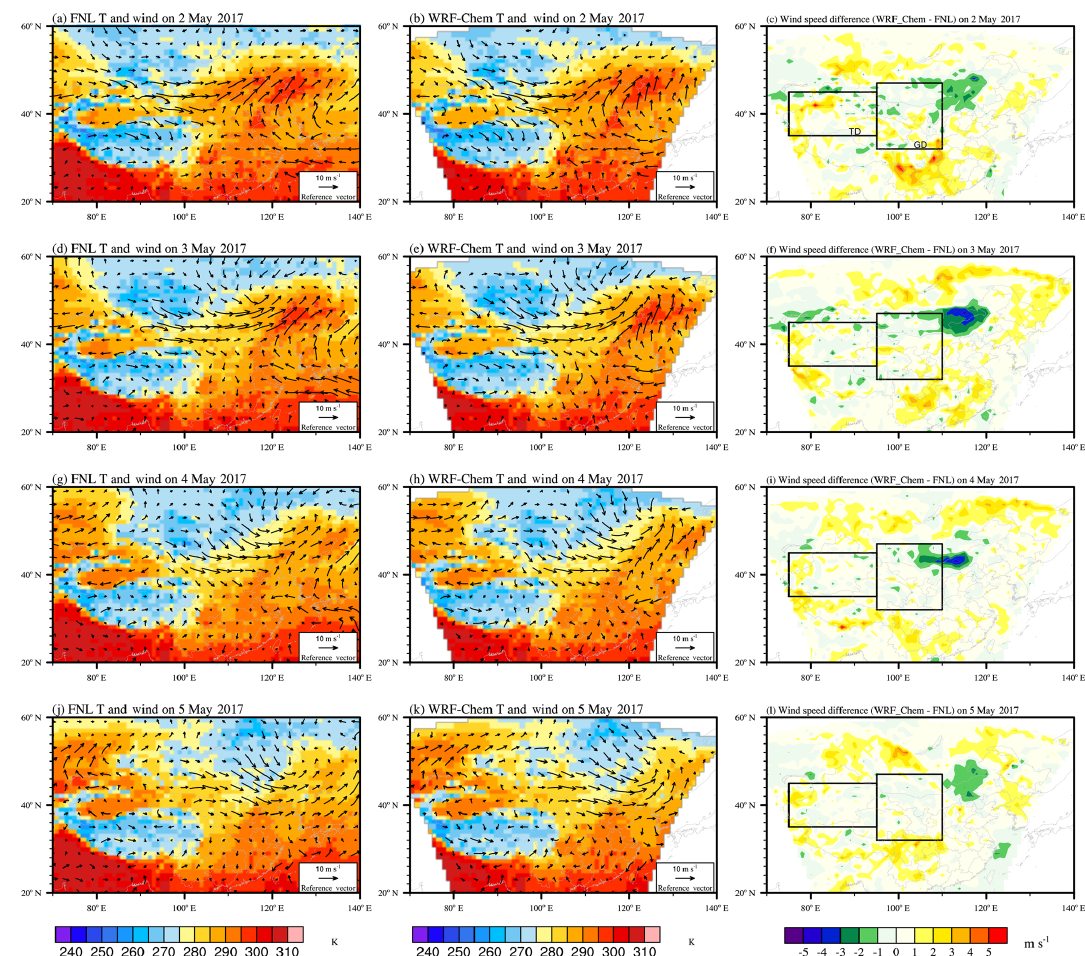
Figure 2. The left two columns show the surface meteorological conditions during the dust event. The color contours show the daily mean temperature field at 2m. Vectors represent the daily mean wind field at 10m. Panels (a) , (d) , (g) , and (j) show the NCEP/FNL reanalysis data. Panels (b) , (e) , (h) , and (k) show the WRF-Chem simulation. The rightmost column shows the difference in daily mean wind speed at 10m between WRF-Chem simulation and NCEP/FNL reanalysis data. The rectangles show the dust source regions. “TD” is the Taklimakan Desert. “GD” is the Gobi